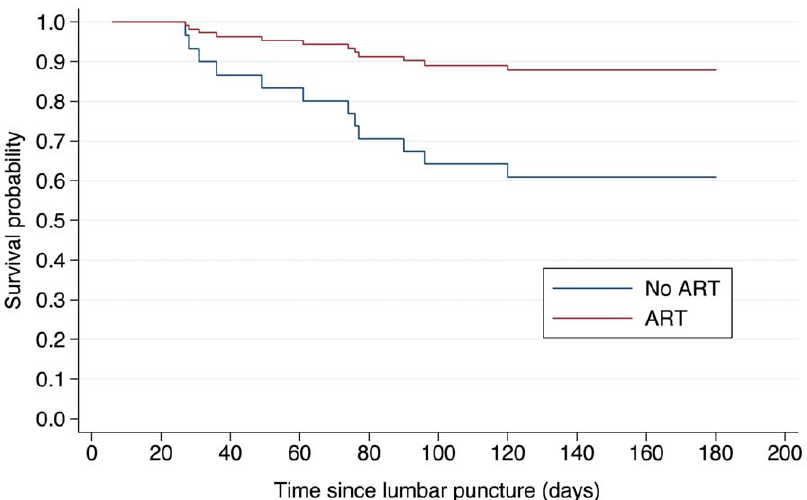
Figure 3. Cox proportional hazard model survival curves. ART : HIV-infected tuberculous meningitis (TBM) patients either on antiretroviral therapy (ART) at TBM presentation or started on ART during subsequent 6 months of antituberculosis (TB) treatment (n=43). No ART : HIV-infected TBM patients not on ART at presentation nor started on ART during subsequent 6 months of TB treatment (n=23). The model only included patients who survived hospitalization (n=66). Hazard ratio for patients on ART=0.30 (95% confidence interval 0.08–0.82, p-value=0.03).